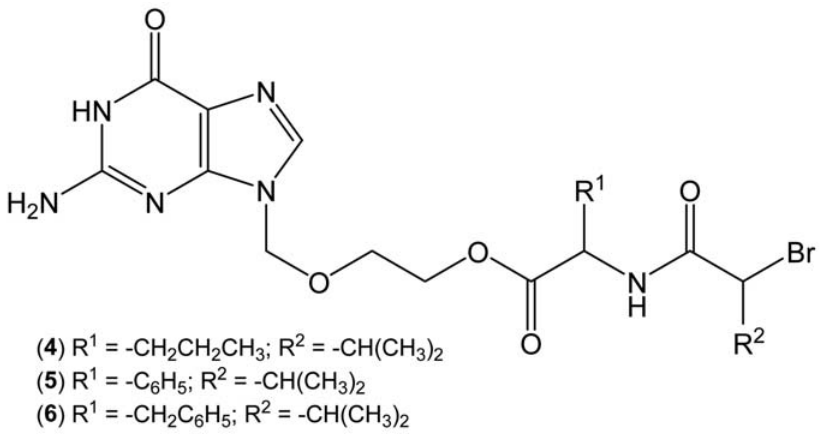
Figure 6. Hypothetical products of the coupling of 1 – 3 to acyclovir.